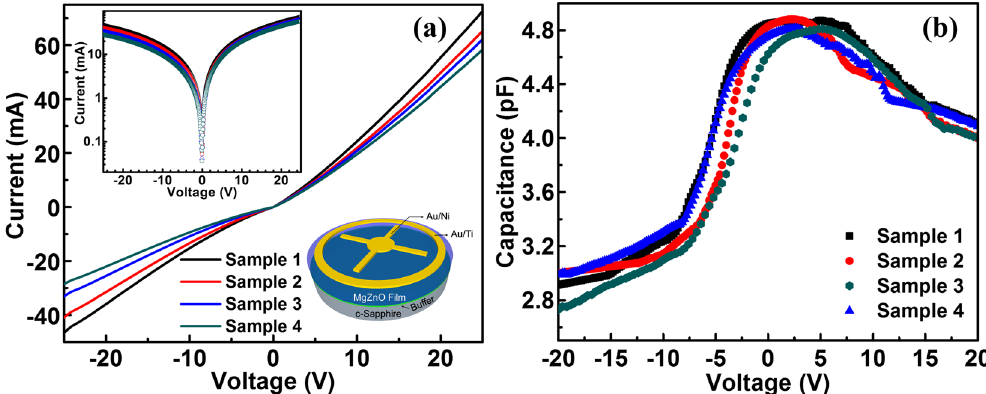
Figure 3. Electrical properties of MgZnO MSM devices. ( a ) I-V characteristics of Samples 1–4. Top left inset displays semi-log plot of I-V data. Bottom right inset shows a schematic of MSM device. ( b ) C-V characteristics of MgZnO MSM devices (Samples